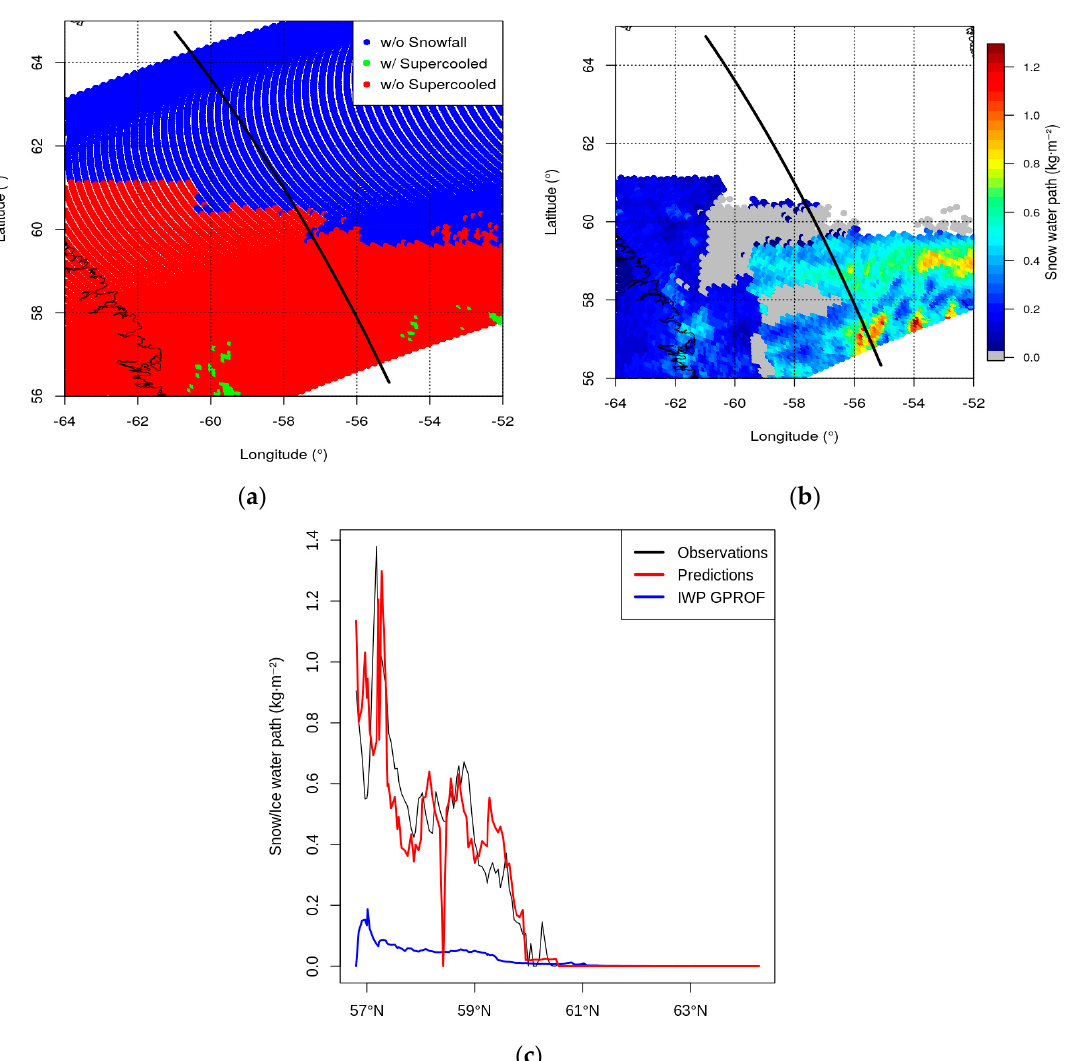
Figure 9. Same as for Figure 7 but for the 27 March 2014 event.